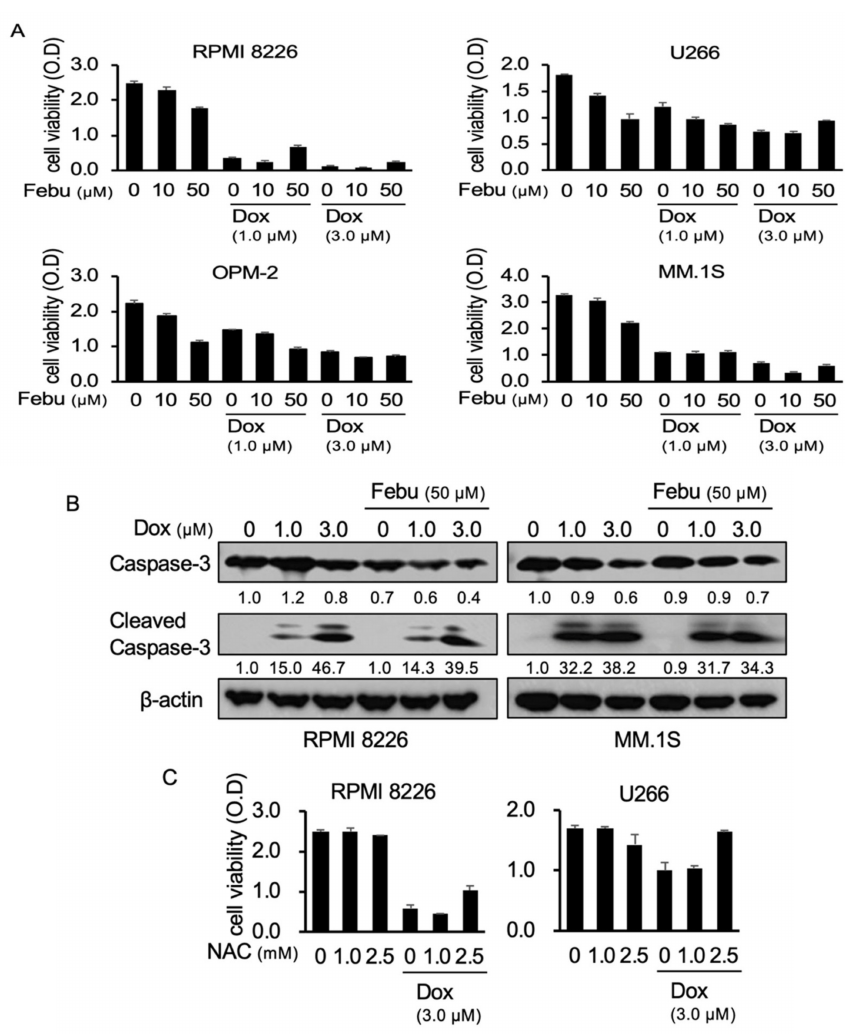
Figure 3. Febuxostat does not compromise the cytotoxic e ff ects of Dox on multiple myeloma (MM) cells. ( A ) The MM cell lines RPMI82266, U266, OPM-2, and MM.1S were cultured in triplicate with the indicated concentrations of Dox and febuxostat (Febu) for 48 h. The cell viability was measured by the WST-8 cell proliferation assay. Results are expressed as mean ± SD. ( B ) RPMI82266 and MM.1S MM cells were cultured with the indicated concentrations of Dox and Febu for 24 h. Caspase 3 and cleaved caspase 3 protein levels were analyzed by Western blotting. β -actin served as a loading control. ( C ) RPMI8226 and U266 MM cells were cultured in triplicate with the indicated concentrations of Dox and / or NAC for 48 h. The cell viability was analyzed by the WST-8 cell proliferation assay. Results are expressed as mean ±